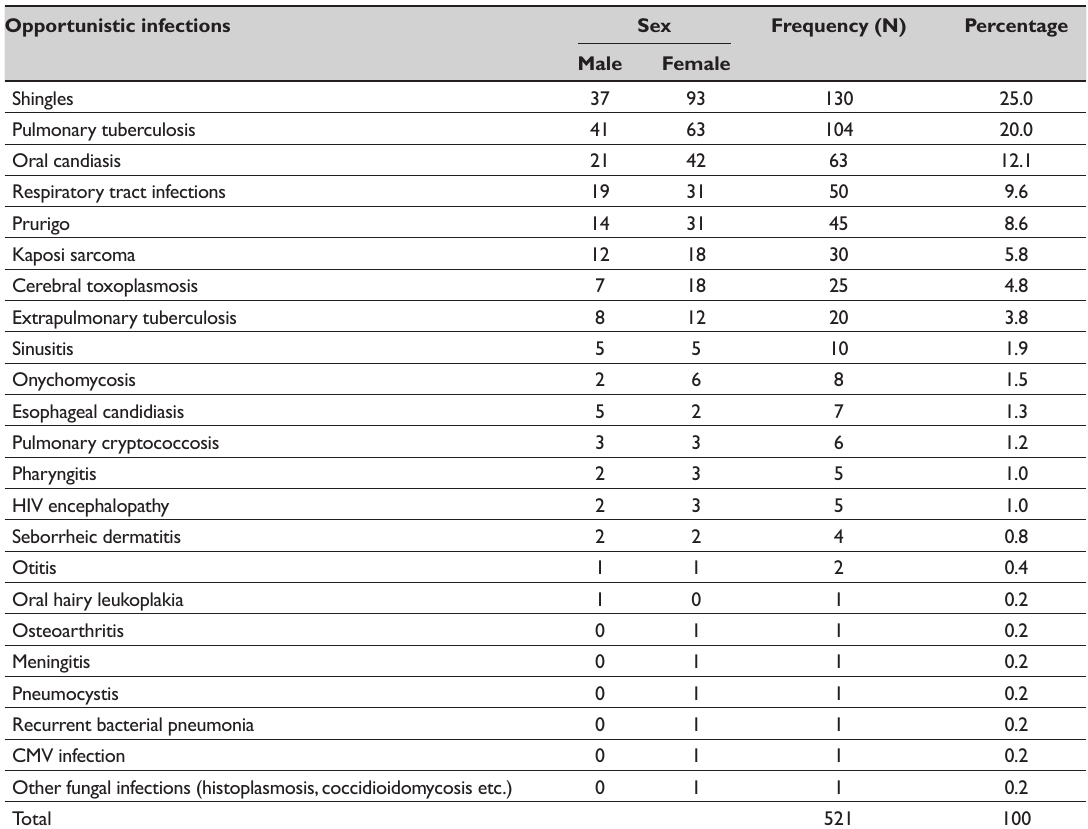
Table 7: Opportunistic Infection distribution Opportunistic